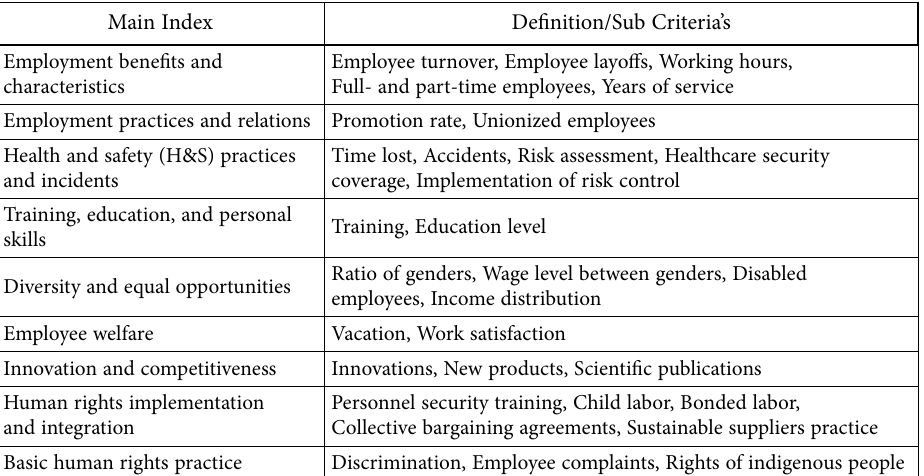
Table 4. Quantitative indexes in corporate social